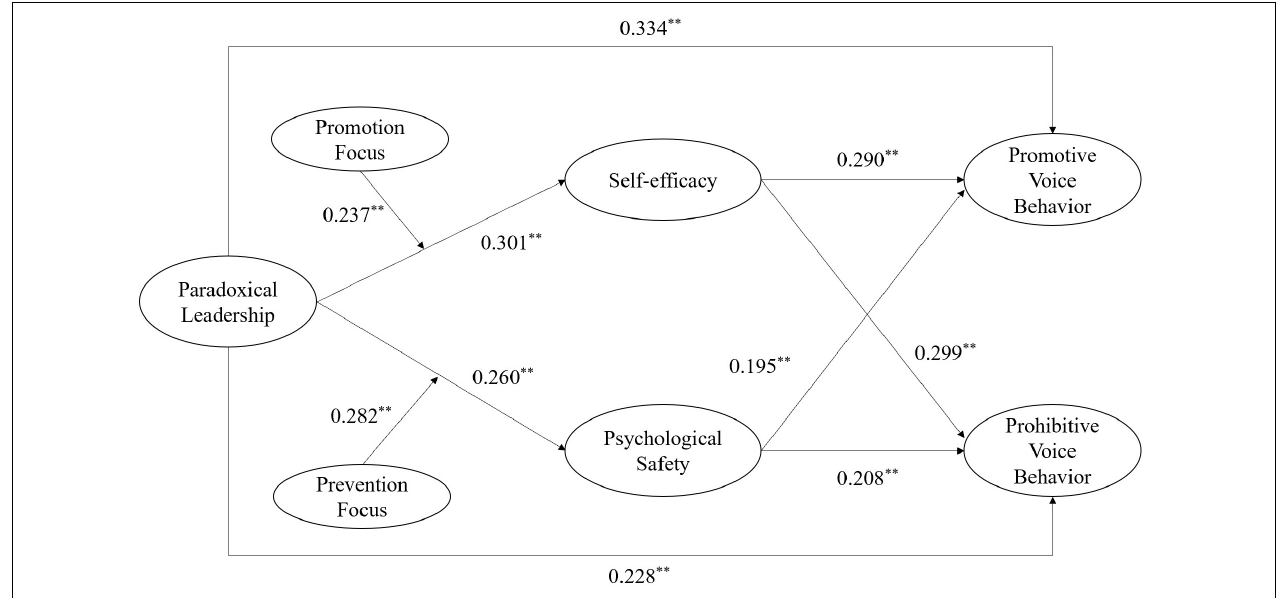
FIGURE 2 | Path Coefficients of the Hypothesis Model.